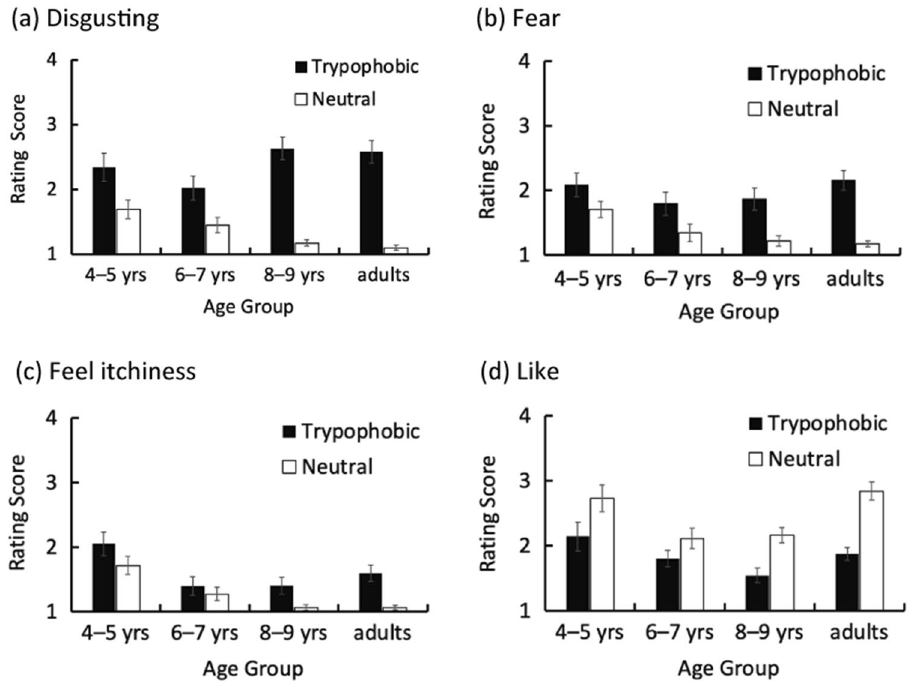
Figure 1. Mean ratings across age groups for the ‘disgusting’ ( a ), ‘fear’ ( b ), ‘feel itchiness’ ( c ), and ‘like’ ( d ) items. The black bars represent the results for the trypophobic images and the white bars represent the results for the neutral image. The error bars represent the mean ± 1 standard error of the mean